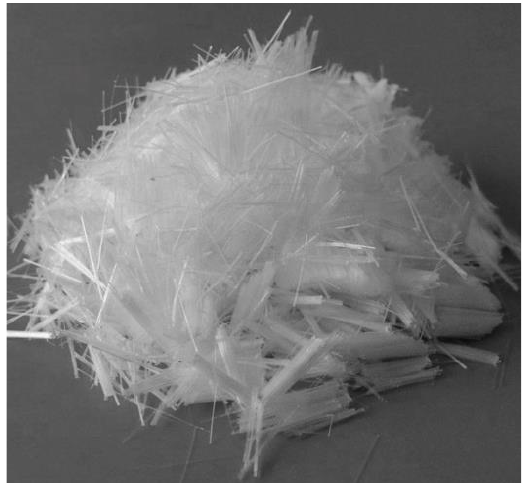
Figure 3. Polypropylene fibers.